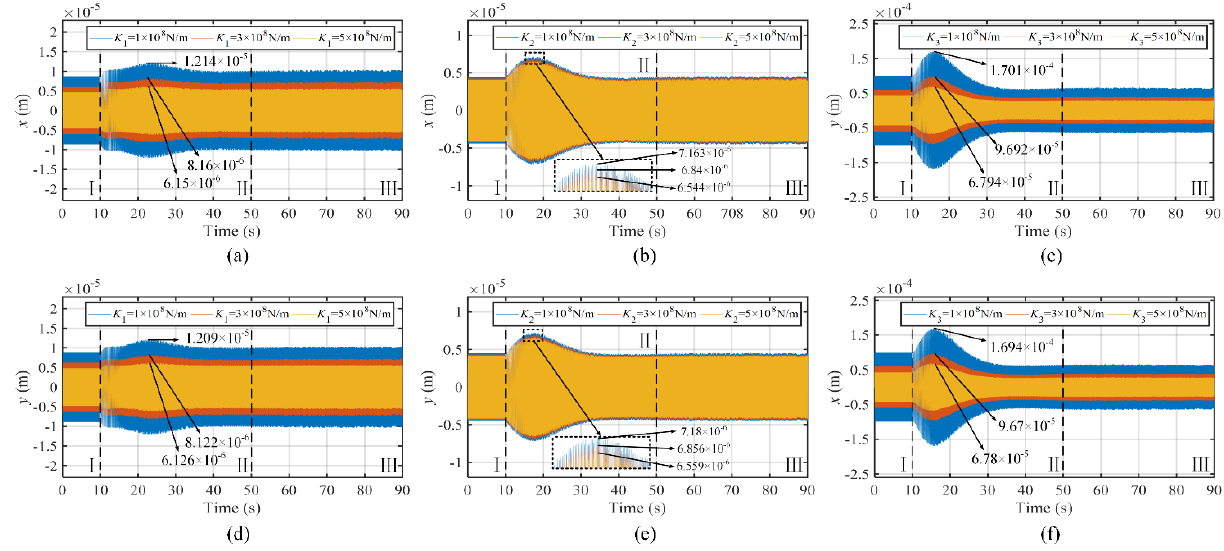
Figure 16. The time-domain figure under different stiffnesses. ( a , d ) Upper guide bearing; ( b , e ) lower guide bearing; ( c , f ) water guide bearing.